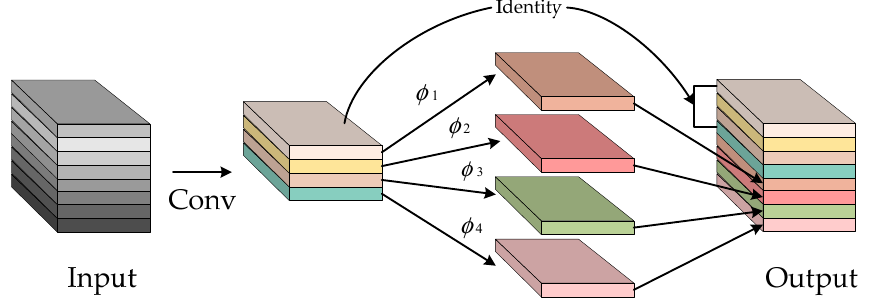
Figure 5. Ghost convolution operation process.